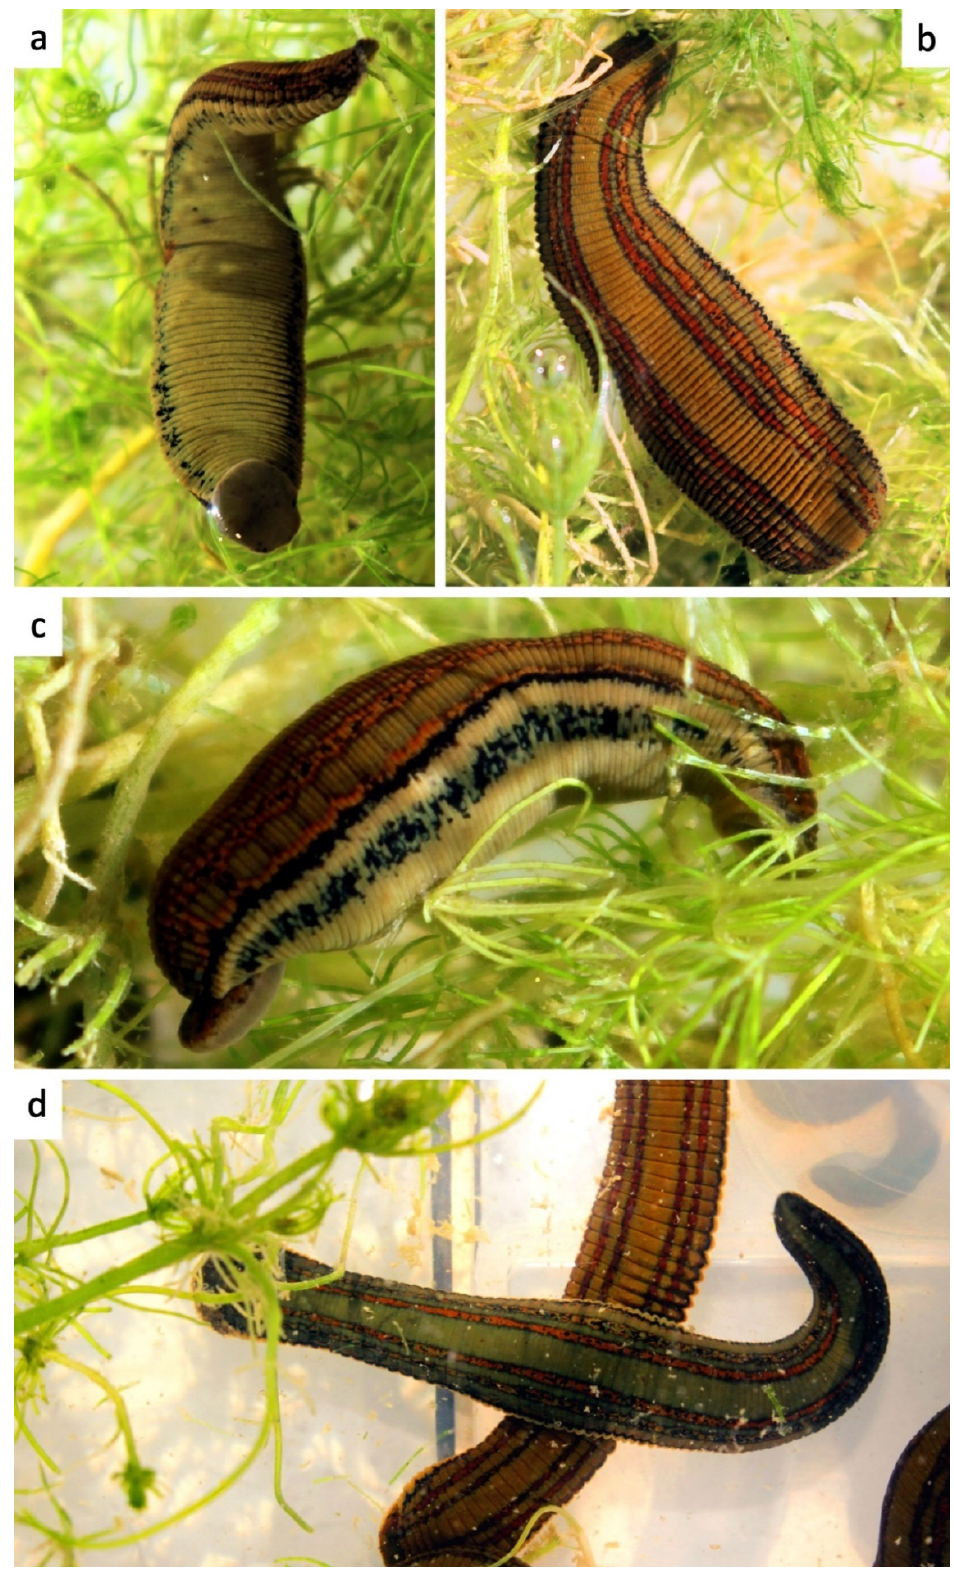
Figure 4. Habitus and colour pattern of living specimens of Hirudo verbana bilineata ssp. nov. from the type locality. ( a , b ) Ventral and dorsal views of holotype; ( c ) lateral view of topotype specimen; ( d ) topotype specimens with greenish background-colour (above) and with brownish one (below).